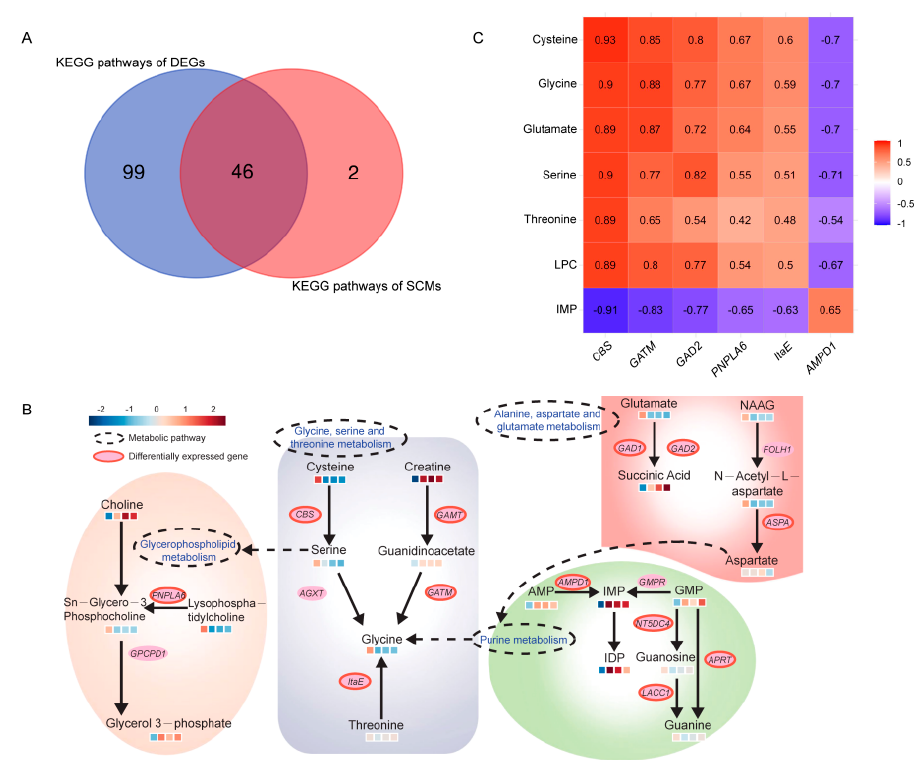
Figure 5. Identification of key metabolic pathways and genes related to the meat flavor of Beijing-You chicken (BJY). ( A ) The number of co-enrichment KEGG pathways of DEGs and SCMs. ( B ) Key pathways of flavor metabolites during BJY development. The blue or orange boxes below the metabolites indicate the contents during BJY development (from left to right: days 1, 56, 98, and 120). ( C ) Correlation between six hub DEGs and seven SCMs. Red indicates that there is a significant positive correlation between this gene and the metabolite, and green indicates a significant negative correlation ( p < 0.05). The numbers indicate the corresponding correlation